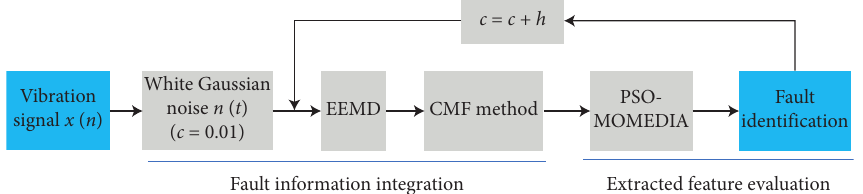
Figure 1: Fault identification process.